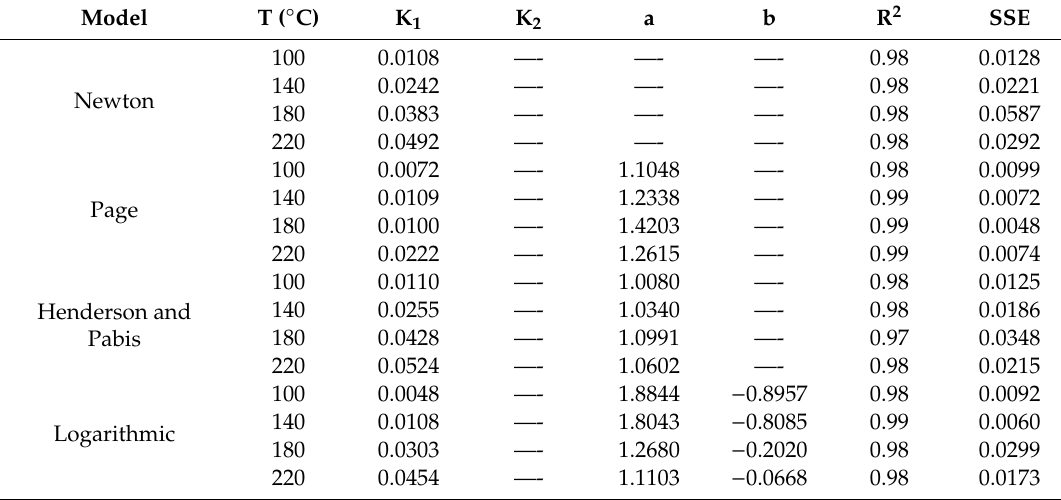
Table 4. Mathematical models applying to experimental data of moisture and their adjusted constants during the cocoa bean roasting